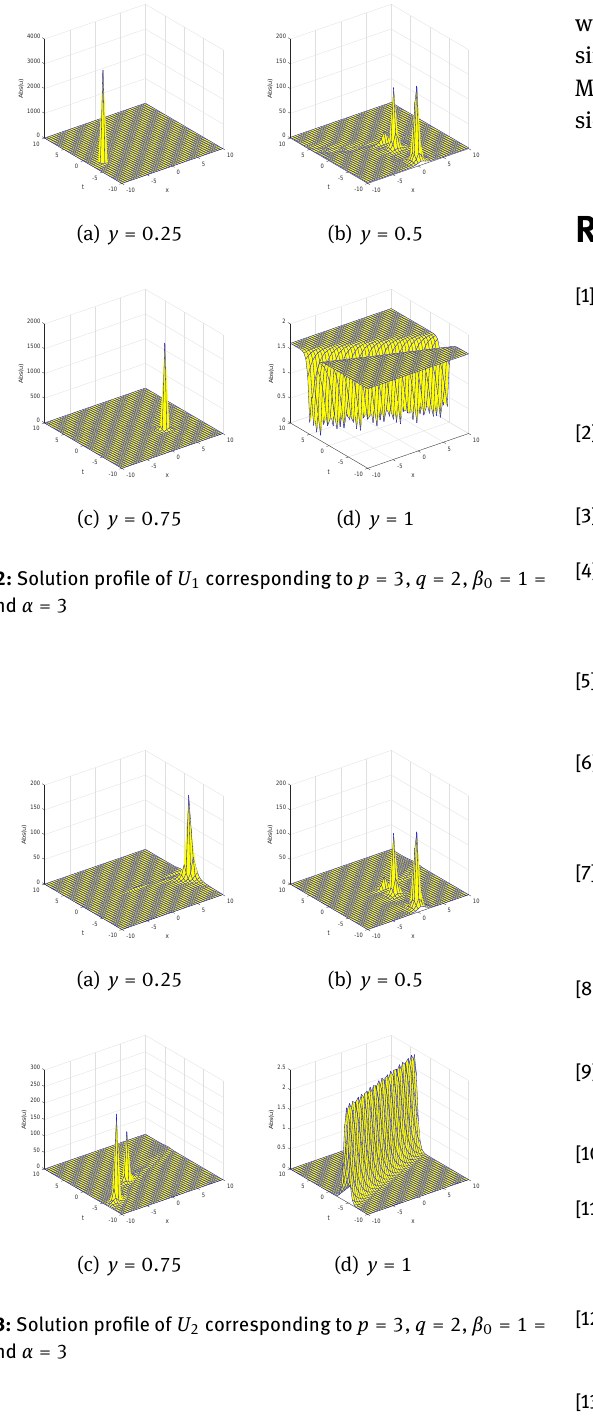
Fig. 3: Solution profile of U 2 corresponding to p = 3, q = 2, β 0 = 1 = β 1 and α =